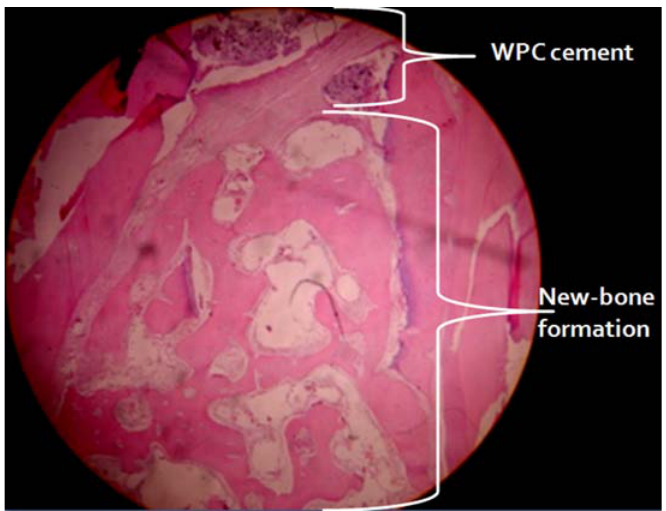
FIGURE 2 – Furcation treated with white Portland cement. New-bone formation